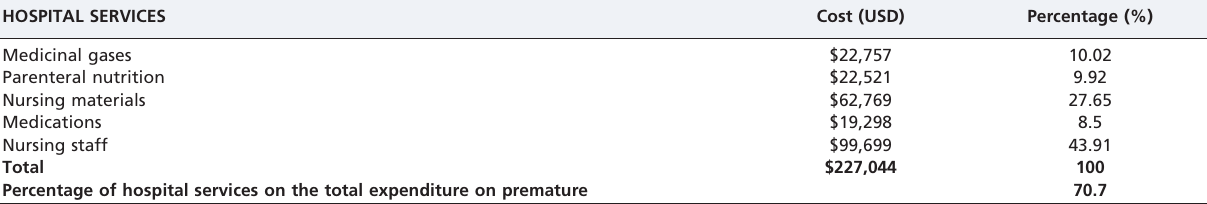
Table 2 - Proportional composition of hospital services (total